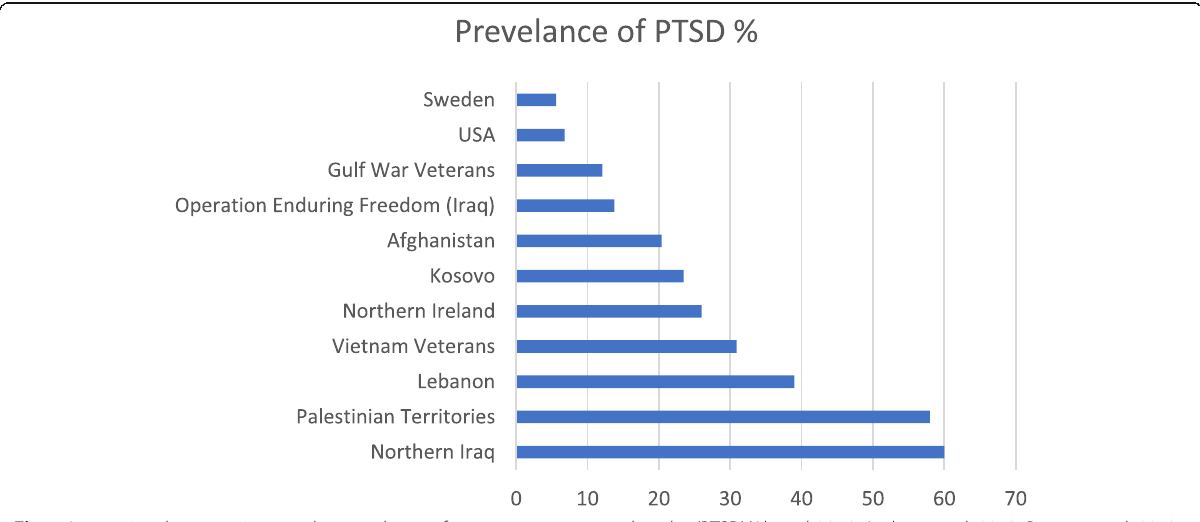
Fig. 1 International perspectives on the prevalence of post-traumatic stress disorder (PTSD)(Ahmad 2016; Arnberg et al. 2013; Bunting et al. 2012; Farhood et al. 2006, Farhood and Dimassi 2012; Gradus 2007; Kilpatrick et al. 2013; Qouta et al.